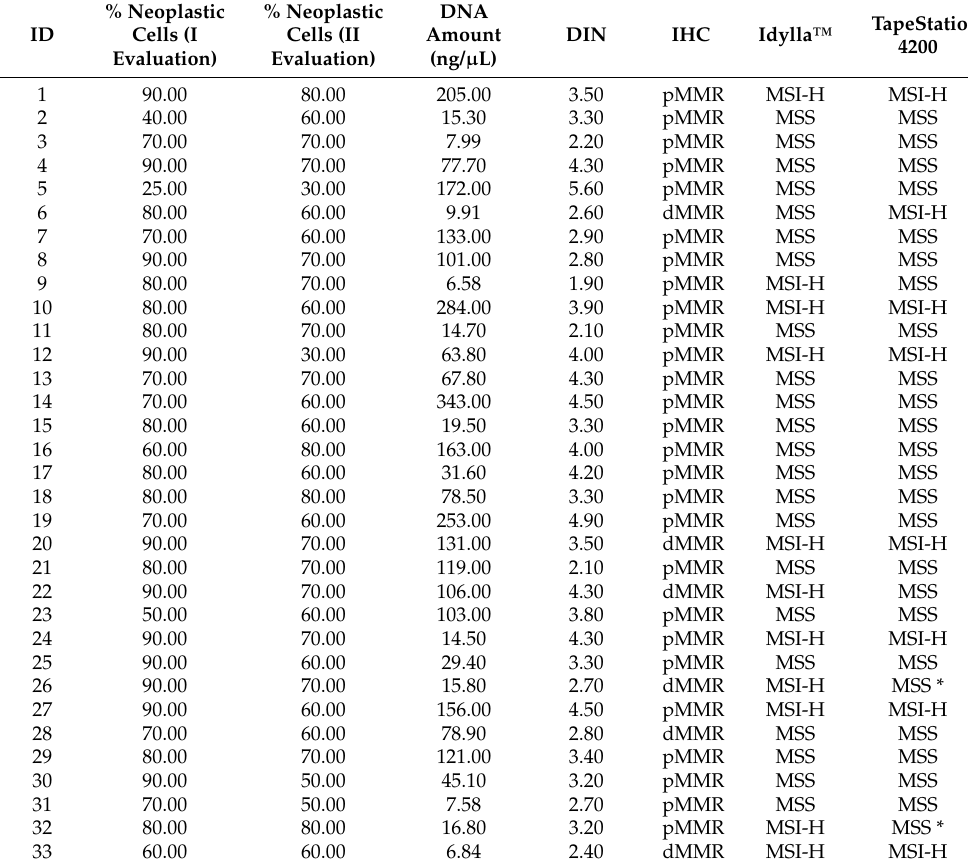
Table 1. Summary of molecular analysis of MMR/MSS status for endometrial cancer patients. % Neoplastic ID Cells